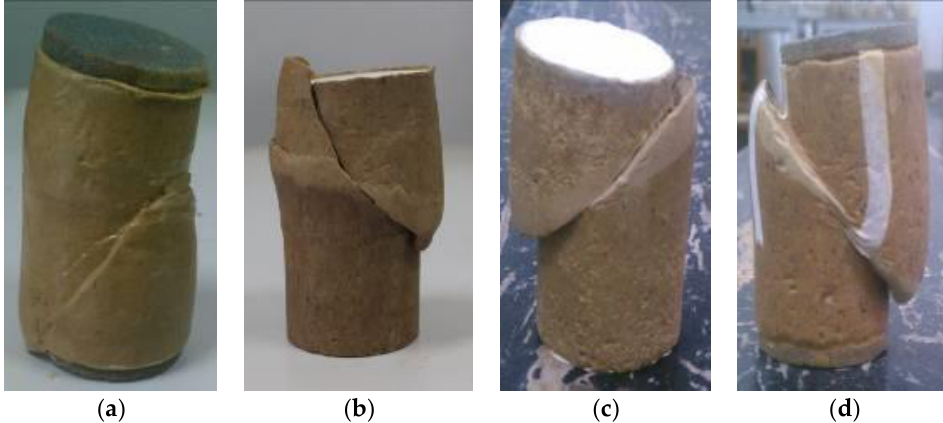
Figure 5. Failure modes of the triaxial samples. ( a ) Without a filled fissure; ( b ) filled fissure with an inclination angle of 15°; ( c ) filled fissure with an inclination angle of 30°; ( d ) filled fissure with an inclination angle of 45°.